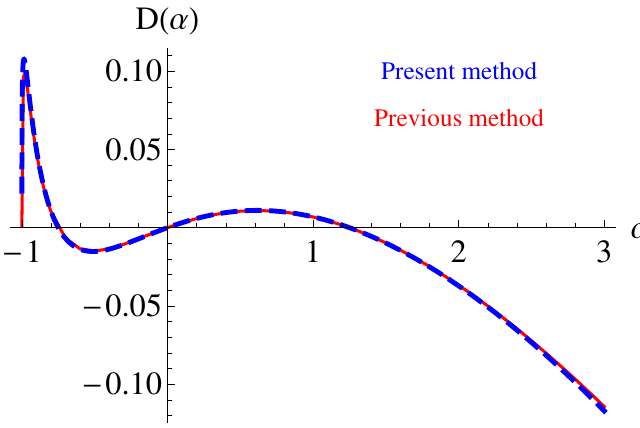
Figure 2. Numerical evaluation of the Evans function E ( α ) for the Equation